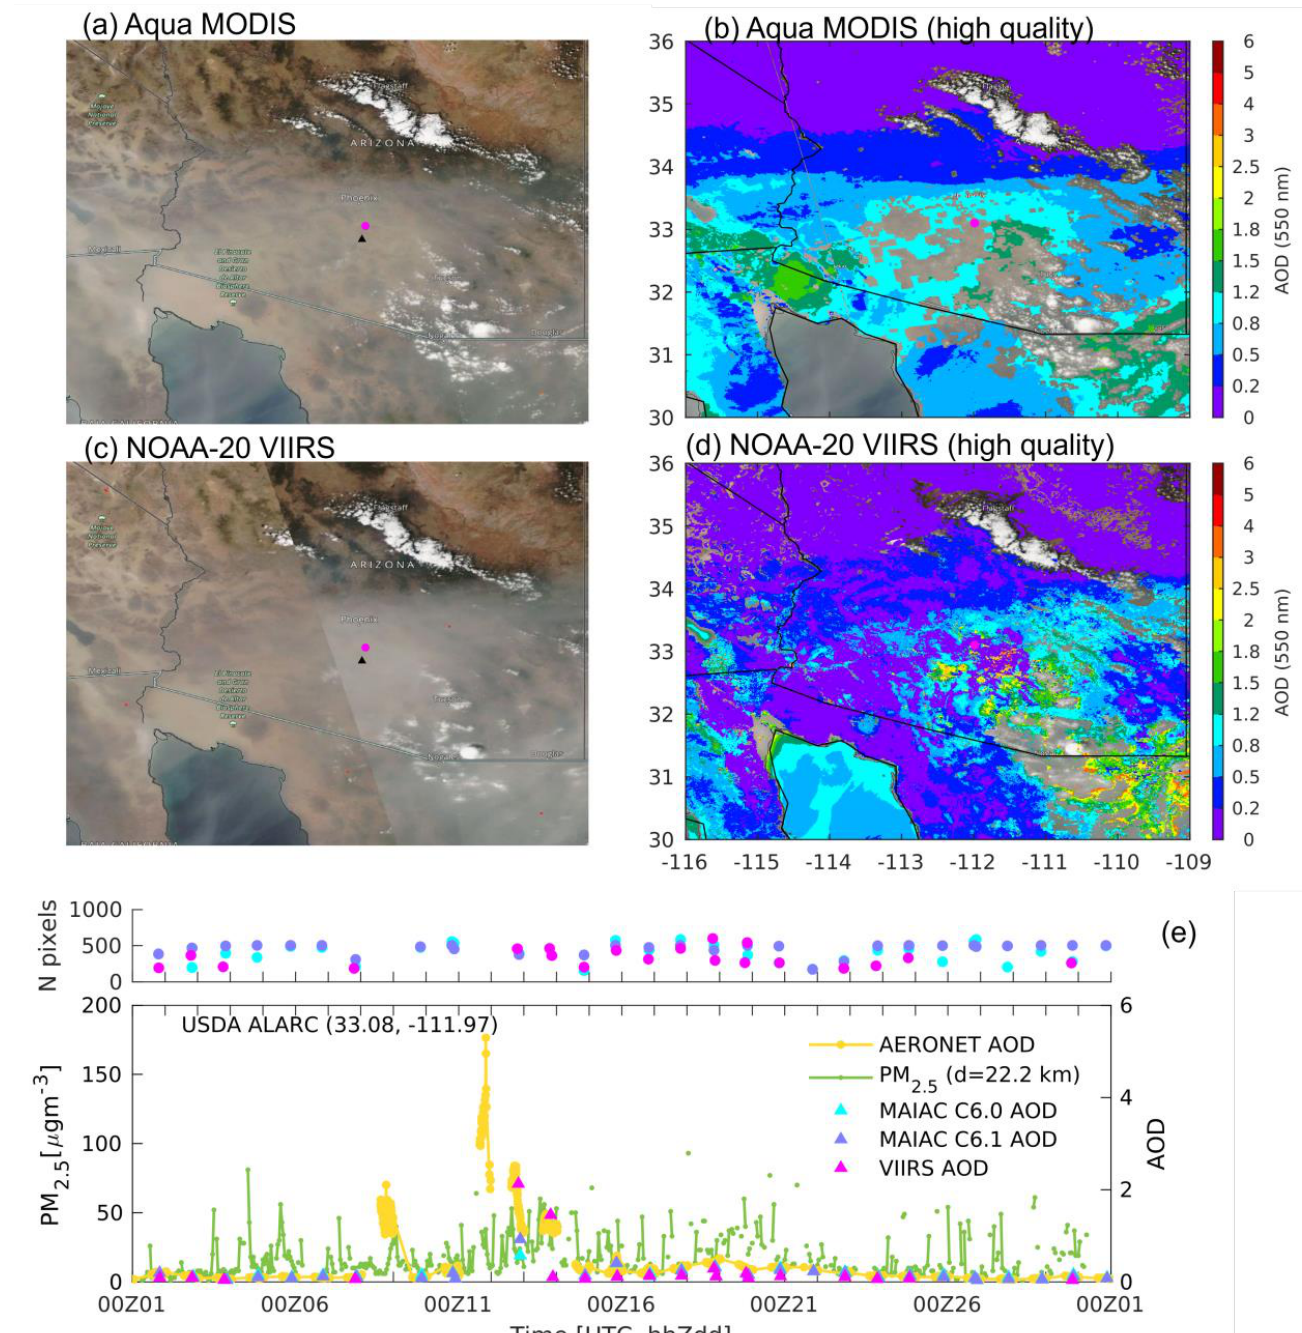
Figure 8. Similar to Figure 6, but for 13 September 2020 ( a – e ). The magenta dot stands for location of the AERONET station USDA ALARC. The satellite AODs have been plotted on top of the true color images.